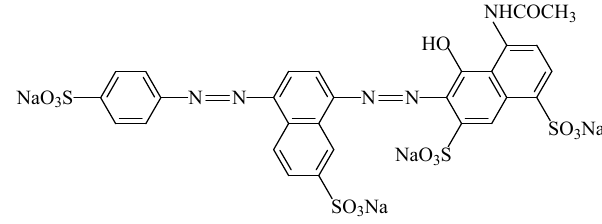
Figure 27. Structural formula of brilliant black PN (E151).